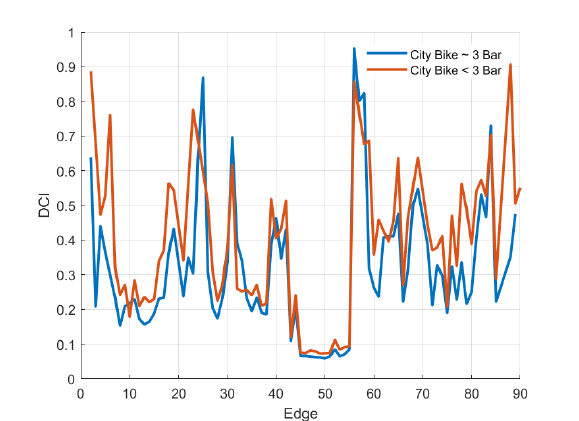
Figure 10. Comparison between two different air pressures on the bicycle wheels. On the x-axis the ridden edges of the test route are sorted by the visit time.